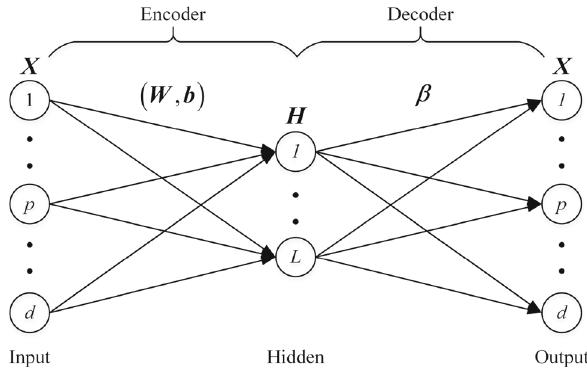
Fig. 2 Network structure of the ELM-AE abstract feature to reconstructed samples. Compared with the traditional AE, the ELM-AE accomplishes fast extraction of abstract feature by applying ELM to AE, and avoids